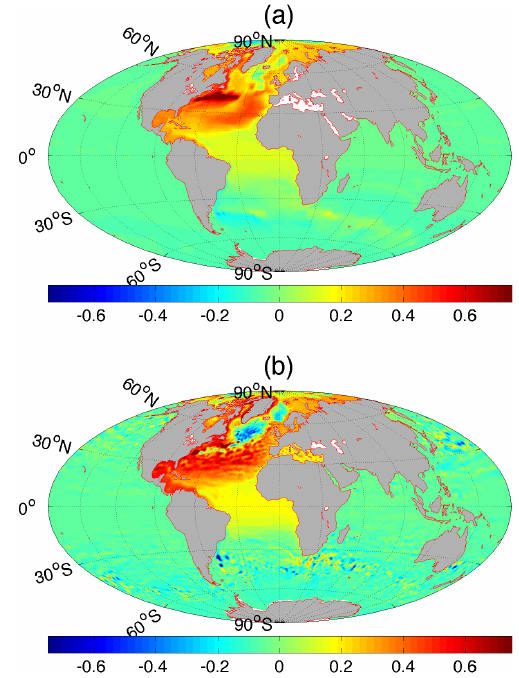
Fig. 2. (a) Change in SSH (hosing - control) after 50 years due to 0.5 Sv of freshwater inflow around Greenland in the LR model. (b) Same as (a) but for the HR model. extremes. G(y) is the fitted generalised distribution function to the GEV distribution of the monthly maximum values of ) > 0 and the region and is defined for y such that 1 + ξ( y − µ σ ξ 6= 0. Results are interpreted as return level z p and return period T (Coles,